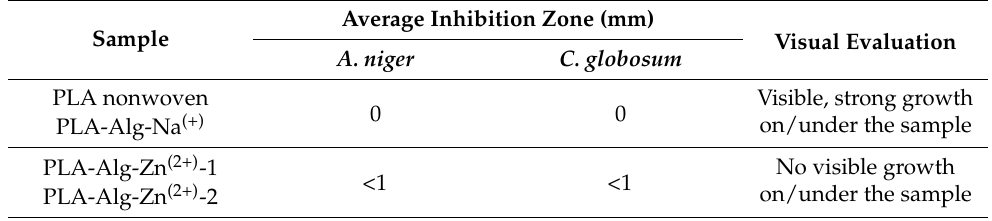
Table 7. Antifungal activity results according to standards EN 14119:2005 of PLA-Alg-Zn (2+) compos-